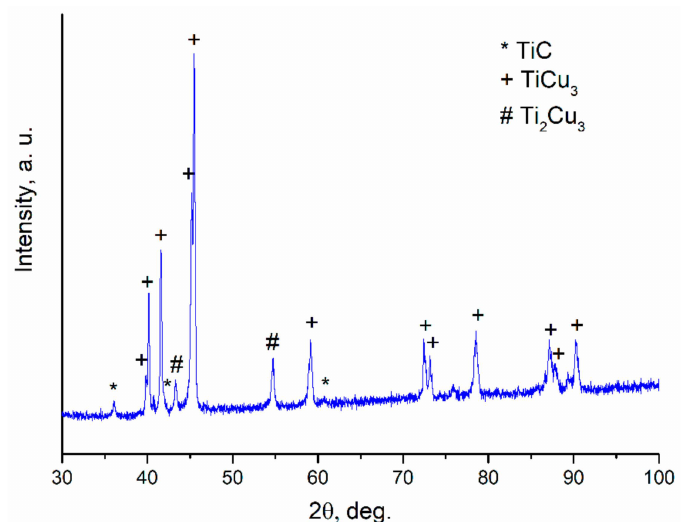
Figure 8. XRD pattern of the specimen obtained by SPS of Ti 25 Cu 75 ribbons in contact with graphite foil (TiCu 3 PDF card 00-007-108). The pattern was taken from the flat end of the disk-shaped specimen, from which the graphite foil was carefully